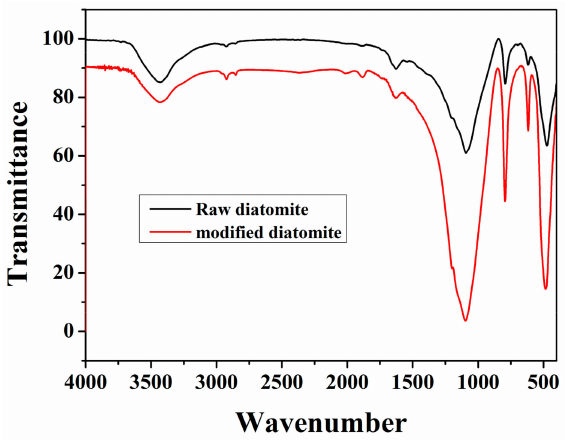
Figure 2. FT-IR spectra of diatomite